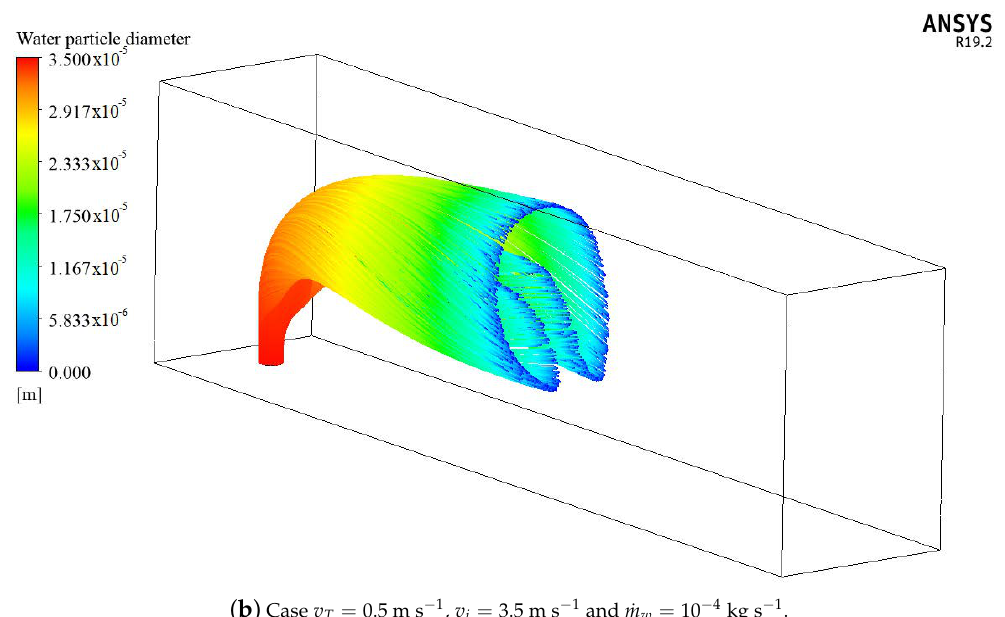
Figure 12. CFD prediction of the droplets’